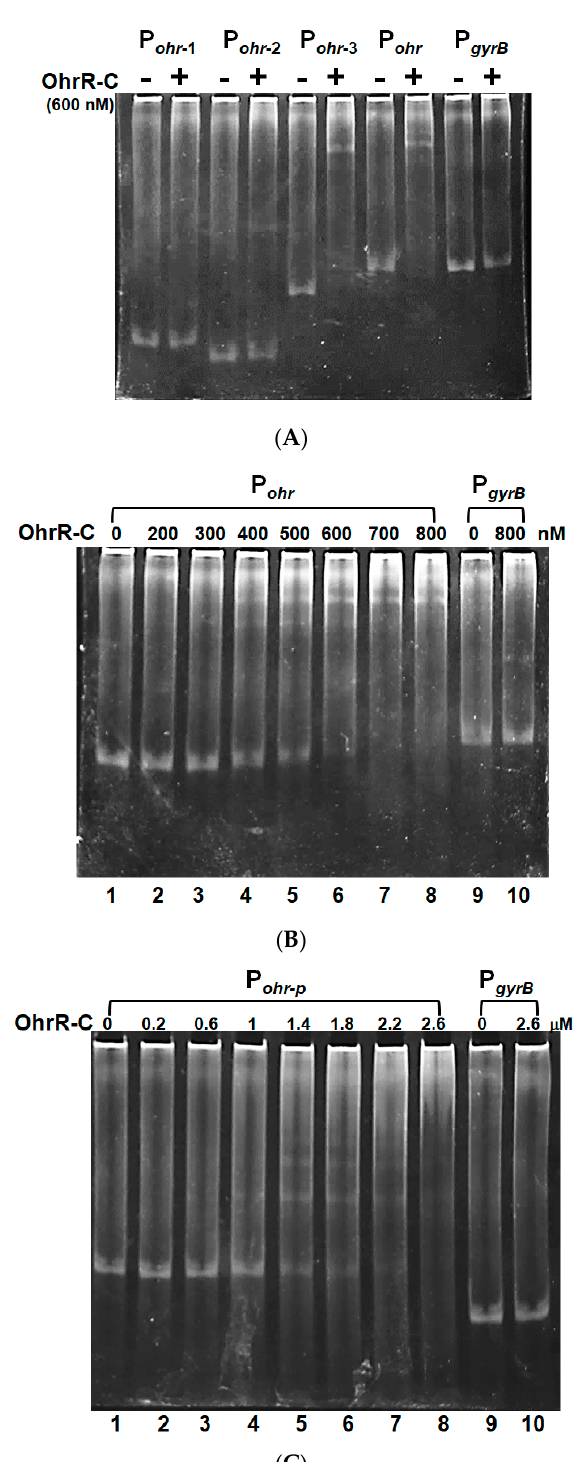
Figure 8. OhrR-C binds specifically to the chromosomal ohrR-ohr intergenic region and the ohr-p promoter region on pMAC. ( A ) OhrR-C (600 nM) incubated with different probes (50 nM). ( B ) P ohr incubated with different concentrations of OhrR-C (0–800 nM). P gyrB is a gyrase gene promoter that was incubated with or without 800 nM of OhrR-C, to serve as a control. ( C ) P ohr-p interaction with different concentrations of OhrR-C (0–2600 nM). P gyrB is a gyrase gene promoter that was also incubated with or without 2600 nM of OhrR-C, to serve as a control. Concentrations of OhrR-C are indicated in the top